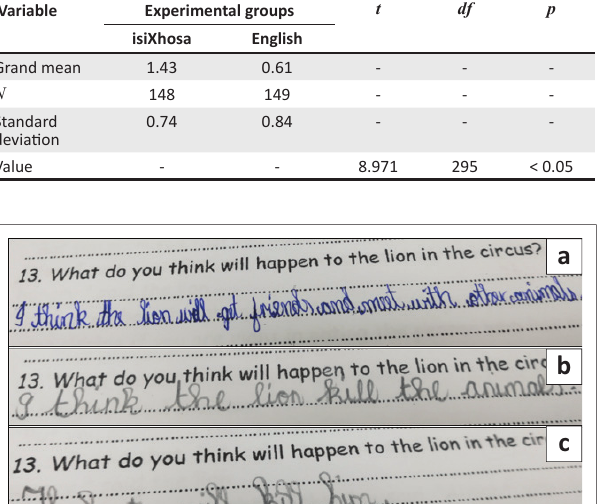
TABLE 10: A comparison of the grand mean scores and p -value on the ability to predict text between isiXhosa and English. Variable Experimental groups